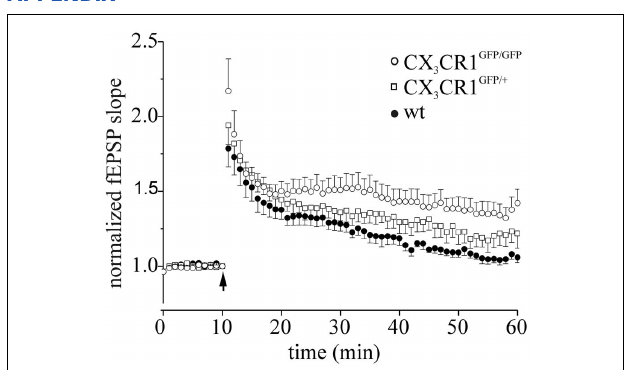
FIGUREA1 | LTP in littermates wt , CX 3 CR1 GFP/GFP and CX 3 CR1 + /GFP mice. Points represent mean ± SEM. Of fEPSP slopes. Arrows indicate time of application of HFS. Note that after HFS, CX 3 CR1 GFP/GFP mice (open circle) developed a robust LTP of fEPSP slope (45min after induction: 1.34 ± 0.28 respect to baseline, 8 slices/3 mice), whereas wt mice displayed no LTP (dark circle, 1.04 ± 0.07, 6 slices/2 mice, p < 0.05 to CX 3 CR1 GFP/GFP ) and heterozygotes (open square, 1.22 ± 0.19, 6 slices/2 mice) an intermediate phenotype,